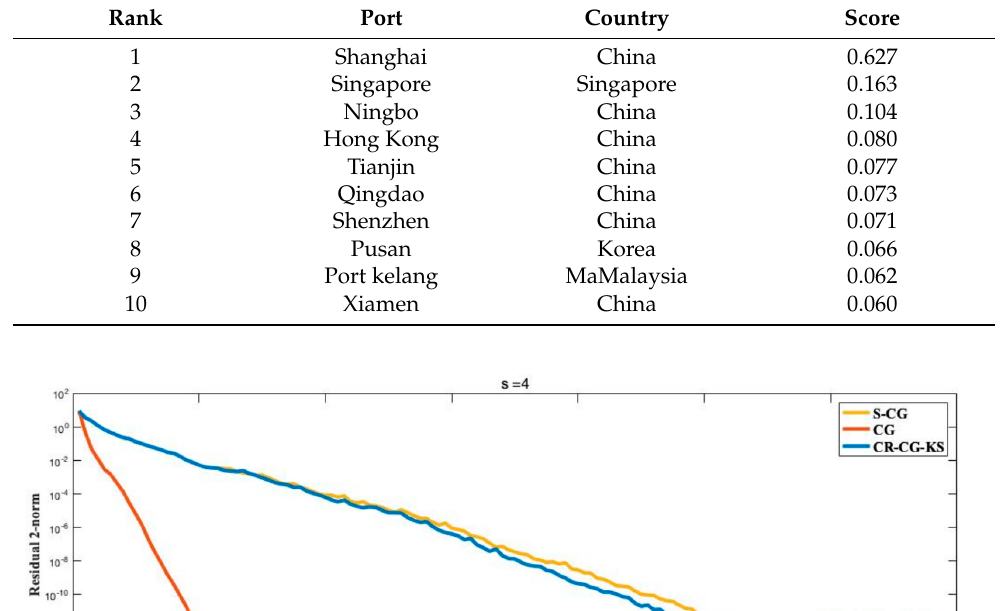
Table 7. Ports with excellent service capacity.